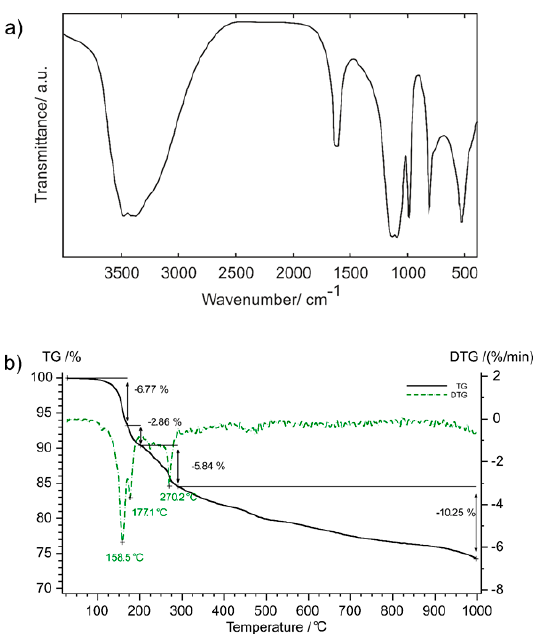
Figure 2. CdPO 3 F(H 2 O) 2 . ( a ) IR spectrum; ( b ) TG curve (black) with its fist derivative (DTG curve, green).